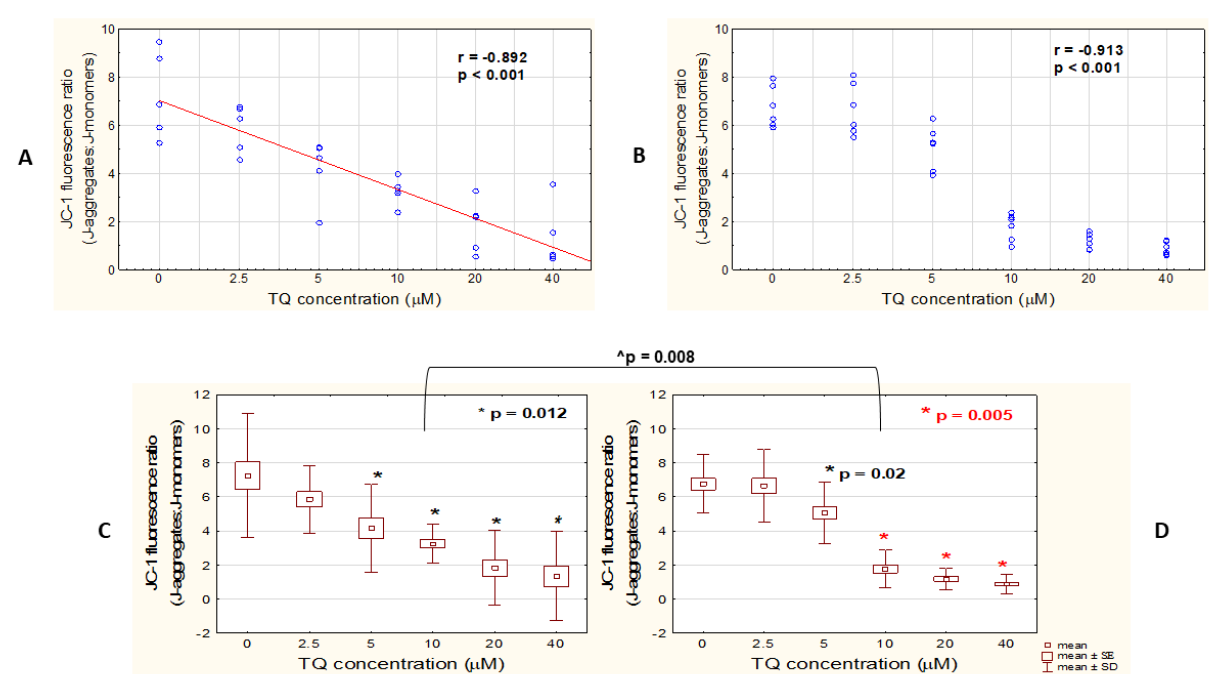
Figure 5. TQ triggers mitochondrial membrane depolarization in A375 and WM9 cells. Spectrofluo- rometric assessment (JC-1) of the mitochondrial membrane potential ( ∆Ψ m ) in A375 ( A , C ) and WM9 ( B , D ) melanoma cells treated with different concentrations of free TQ for 48 h. The decrease in ∆Ψ m is expressed as a drop in J-aggregates/J-monomers ratio. ( A , B ): Spearman correlation analysis of the data shows the relationship between the concentration of free TQ and ∆Ψ m . Spearman correlation coefficient (r) and p-value are shown. ( C , D ): Decrease in ∆Ψ m in relation to DMSO control (presented as 0 μ M TQ concentration). * denotes significant differences between the TQ-treated cells and con- trol (Mann – Whitney U test); ^ denotes significant differences between the two analyzed cell lines (Mann – Whitney U test); data are presented as mean ± SD; all the results were considered statistically significant when p < 0.05.